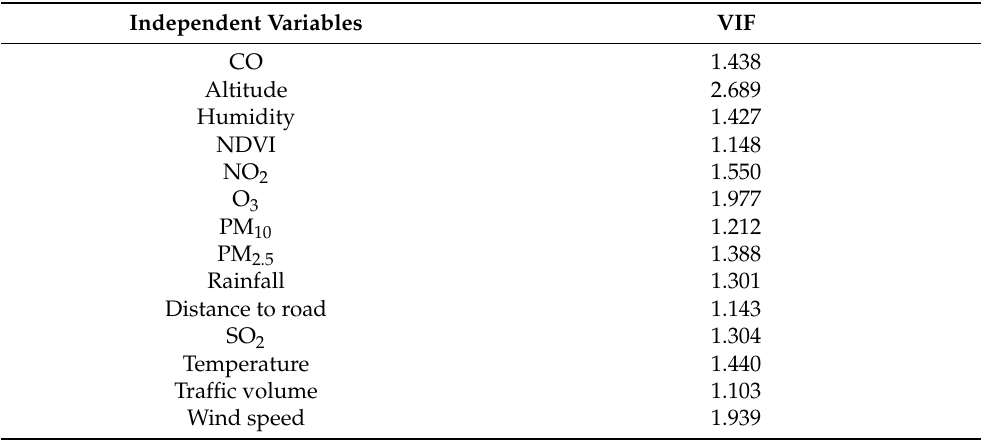
Table 2. Result of multicollinearity